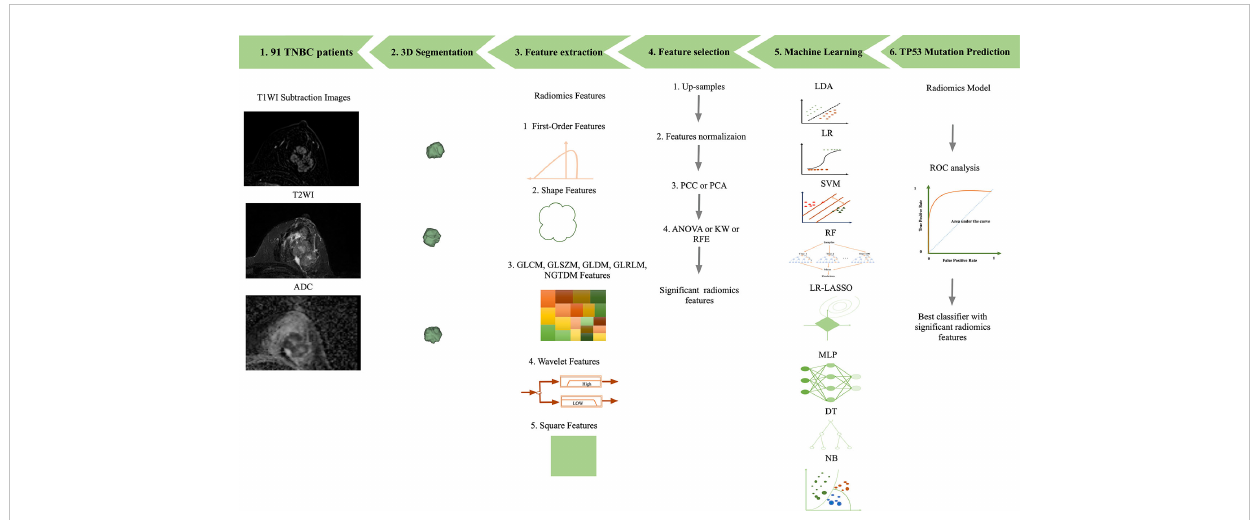
FIGURE 1 Work fl ow of image processing. 1) T1WI, T2WI, and ADC data of 91 breast cancer patients. 2) 3D segmentations of lesions shown as surface-shaded 3D renderings. 3) Extraction of radiomic features, i.e., fi rst-order, shape, texture features, square and wavelet features 4) feature selection. 5) Eight machine learning classi fi cations were all performed. 6) ROC analysis was used to assess the diagnostic performance of the radiomics model in the detection of TP53 mutations in